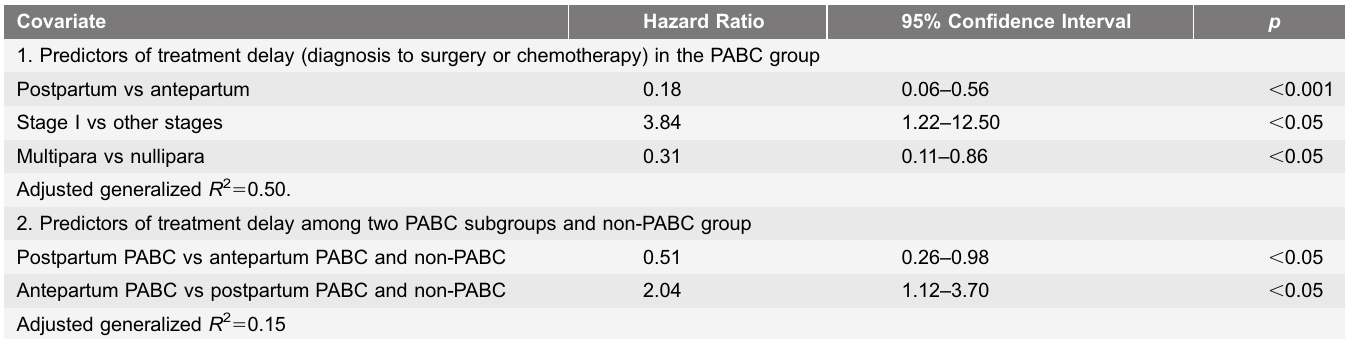
Table 2. Multivariate Analyses of Predictors of Treatment Delay using the Cox Model.